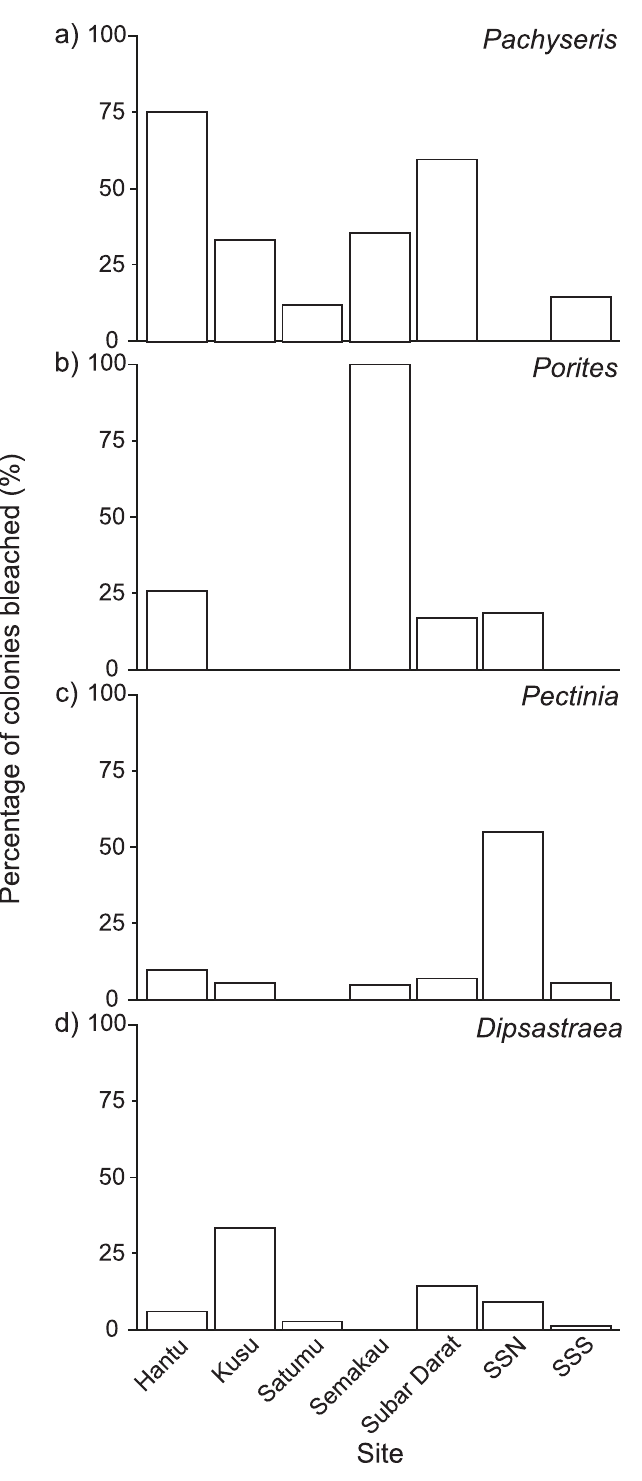
Fig 3. Coral bleaching susceptibility across seven study sites during a minor bleaching episode in Singapore in 2013. Four genera with the largest number of bleached colonies in each site are presented: (a) Pachyseries , (b) Porites , (c) Pectinia and (d) Dipsastraea . Corals of the genus Pachyseris were not recorded at Sultan Shoal North (SSS = Sultan Shoal South; SSN = Sultan Shoal North).